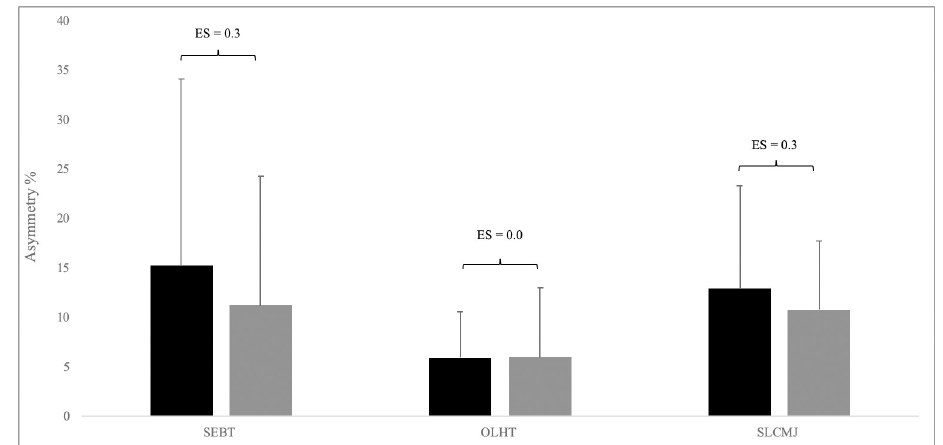
Fig 1. Mean inter-limb asymmetry values ± standard deviations (error bars) for males (black bars) and females (grey bars) during the star excursion balance test (SEBT), one legged hop test (OLHT) and single leg countermovement jump (SLCMJ) tests. ES = effect size.